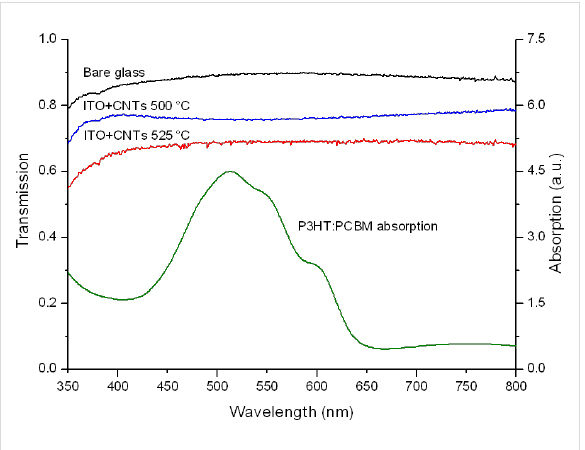
Figure 2: Transmittance spectra of the electrodes (left Y axis), compared to the absorption spectrum of the P3HT:PCBM blend (right Y